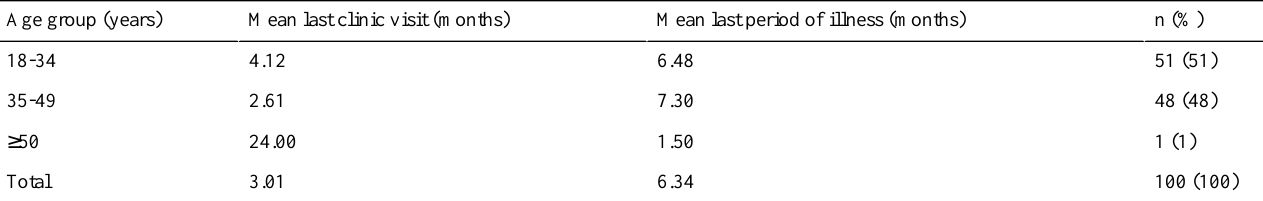
Table 1. Clients’mean last clinic visit and last period of illness in months by age